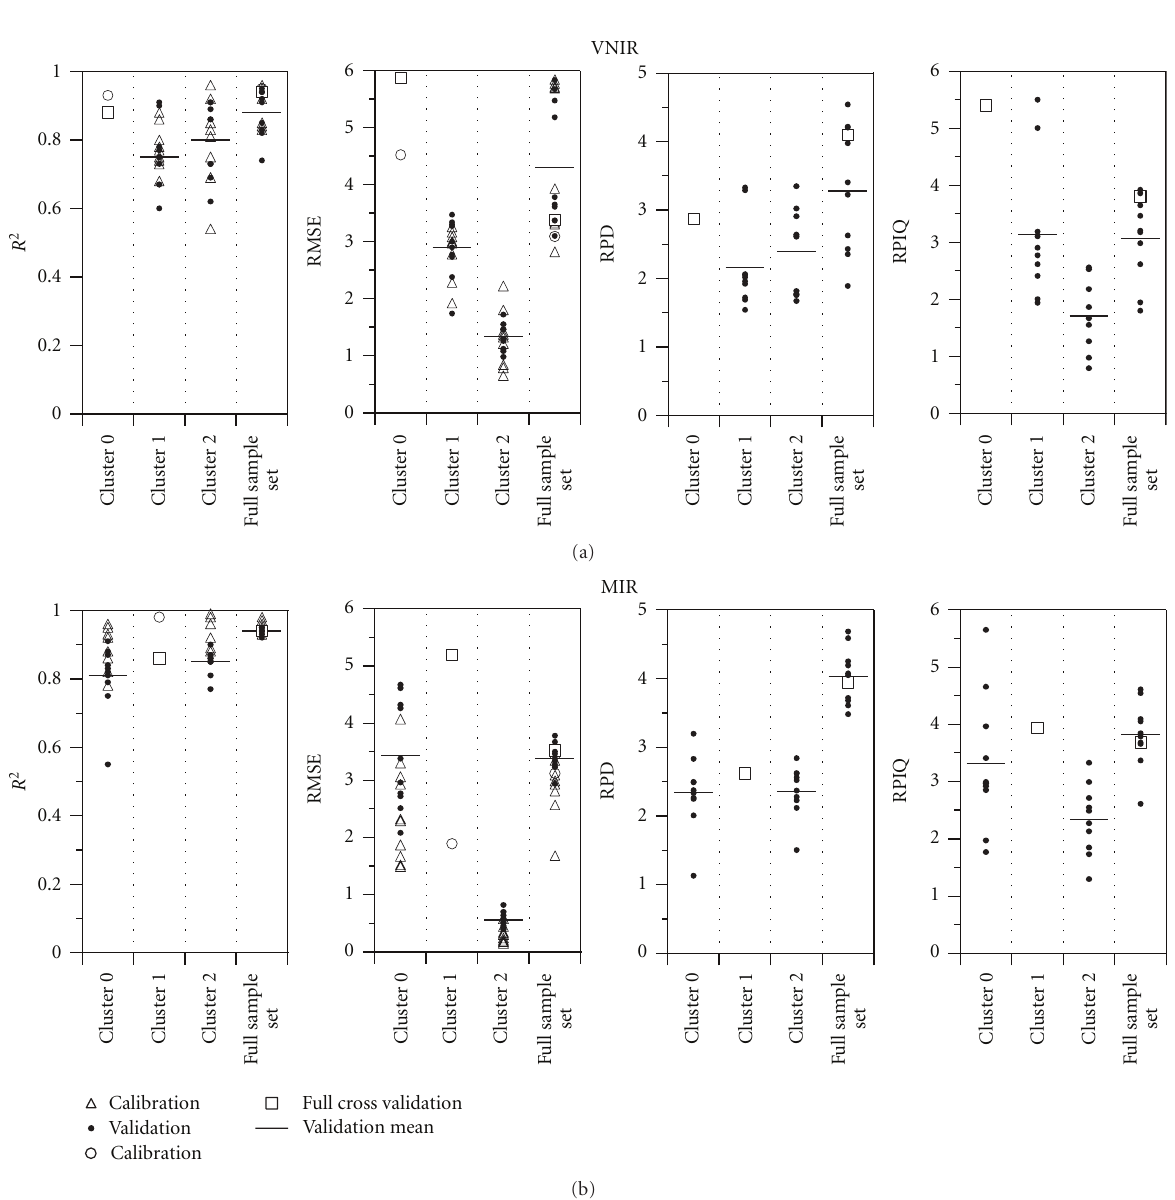
Figure 5: Visual assessment of partial least squares regression model results for soil total carbon (C t ) prediction from the subsets of (a) visible/near-infrared (VNIR) and (b) mid-infrared (MIR) di ff use reflectance spectra based on spectral classification with k -means cluster analysis. The parameters given are the coe ffi cient of determination ( R 2 ), root mean squared error (RMSE, %), residual prediction deviation (RPD), and the ratio of performance to interquartile distance (RPIQ). The range of values reflects the results of 10 random iterations of the models. Results are also shown for full sample set models with no subsetting for